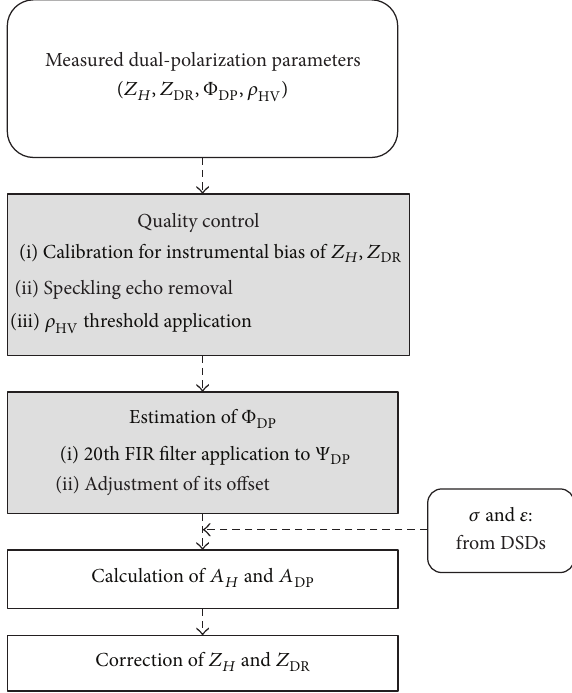
Figure 4: The schematic diagram of the attenuation correction